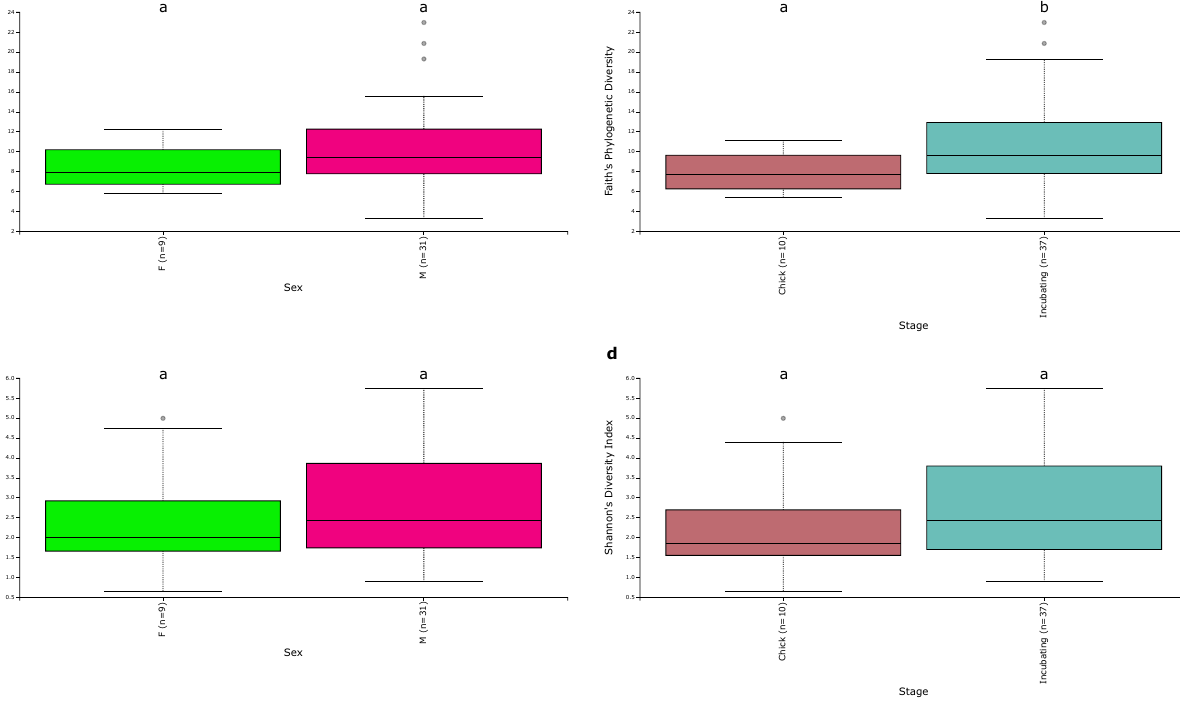
Figure 4. Differences in Faith’s phylogenetic diversity for the gut microbiome with no differences between sexes ( a ) but evidencing differences between reproductive stages ( b ) and showing no differences in terms of Shannon’s Diversity Index ( c ) between sexes or ( d ) between reproductive stages. Letters above boxplots represent differences between groups with p < 0.05.